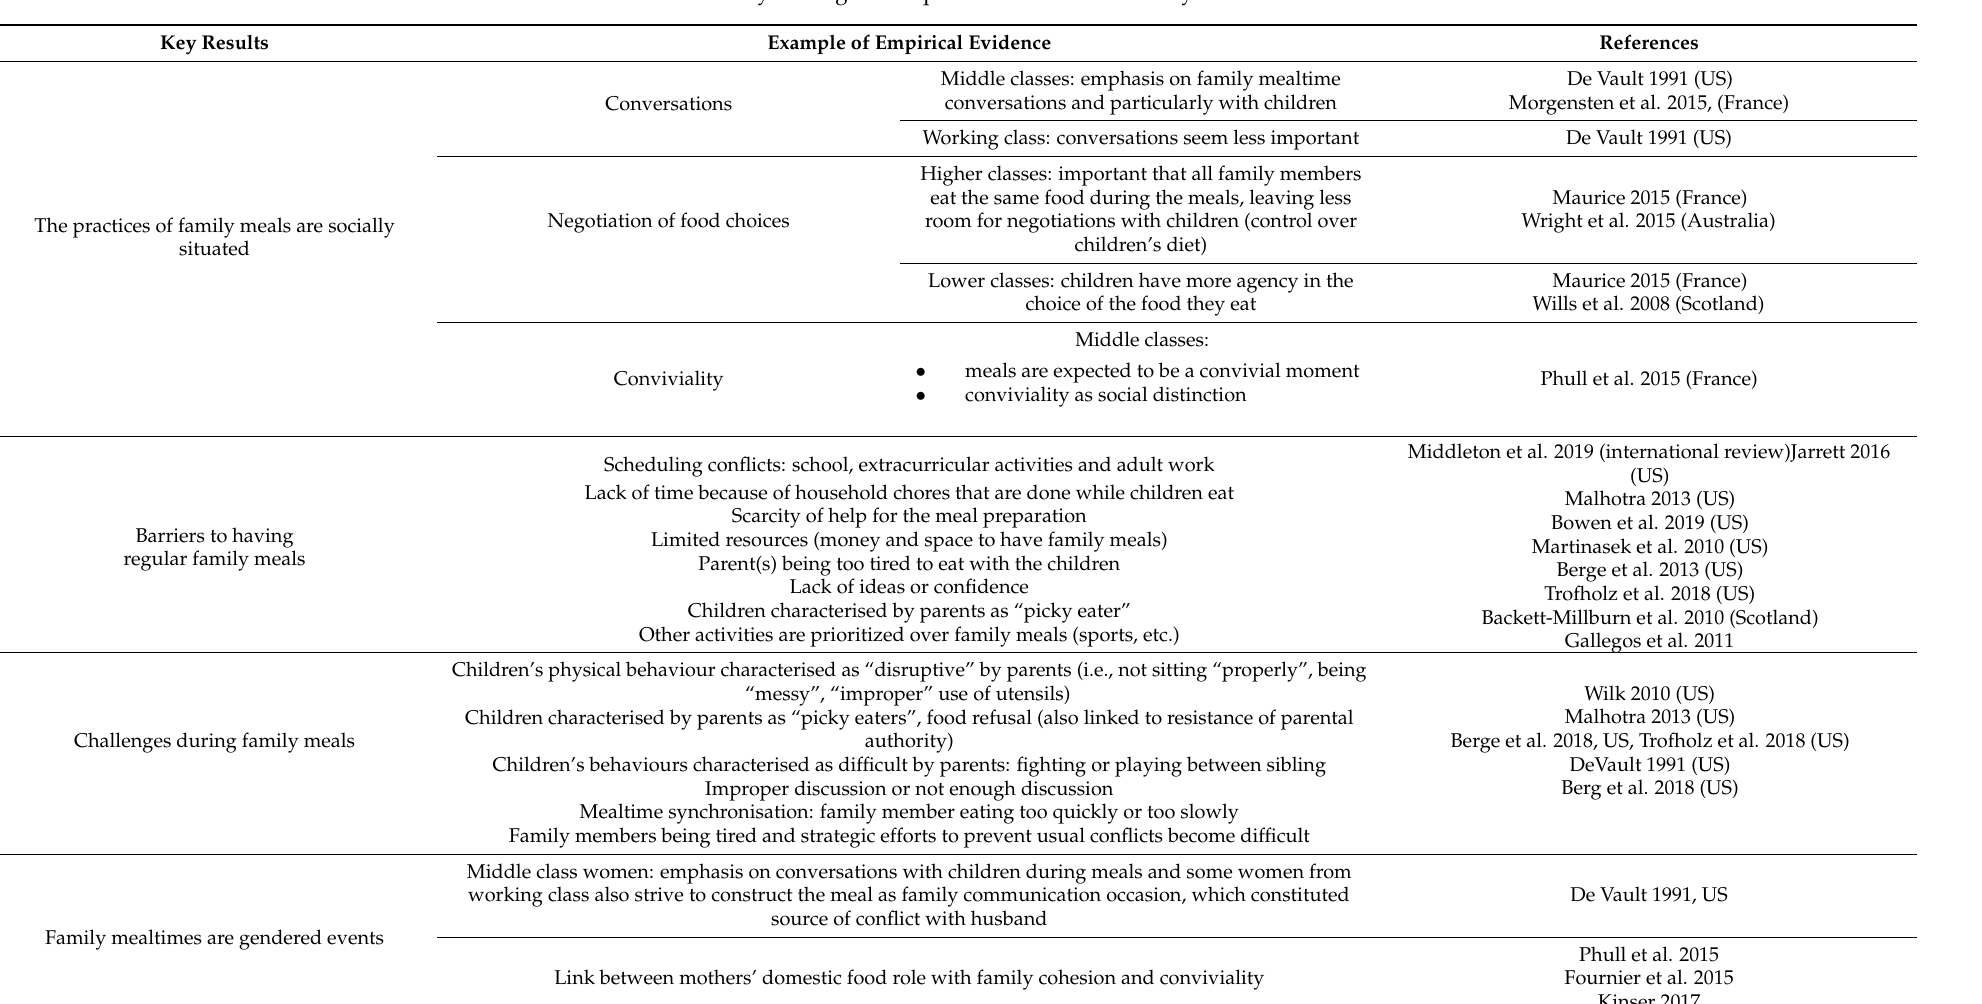
Table 4. Key findings from qualitative studies of family